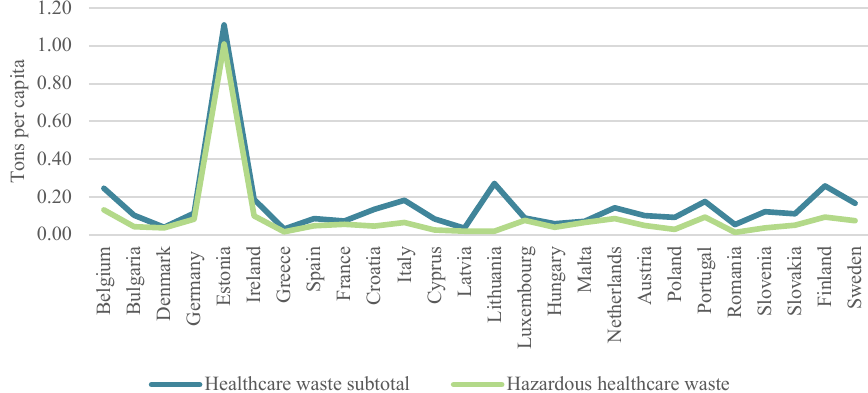
Fig. 1. Healthcare waste subtotal and hazardous healthcare waste tons per capita on average per 2004–2016 data, Eurostat data [13], [14]. Healthcare waste morphological analysis depends on the season, healthcare facility type and other factors and in this respect, healthcare waste heterogeneous [15]. Healthcare waste from disaster relief consists of plastic (43.2 %), biomass (26.3 %), synthetic fibre (15.3 %), rubber (6.6 %), liquid (6.6 %), inorganic salts (0.3 %) and metals (1.7 %) waste [16]. From children’s hospitals healthcare waste consists of plastic (39.3 %), paper (11.15 %), textile (23.8 %), glass and sharps (22.7 %) and other (3.05 %) waste [17]. Common healthcare waste from a clinical pathology laboratory includes infectious waste (69.3 %) – sharps (8.6 %), blood collation tubes (37.4 %), other collectors (17.4 %) and other waste, such as toxic waste (8.6 %), infectious-and-toxic waste (13.7 %) and household types of waste (8.4 %) [18]. Based on literature, the main components of healthcare waste are plastic (39.3 – 50 %), textile (14–31 %), paper (11.2–25 %), glass (0.3–22.7 %), woodware (3.2–20 %), rubber (3.4–6.6 %), metal (0.3–5 %) and other (1.4–18.6 %) waste [15]. The main healthcare